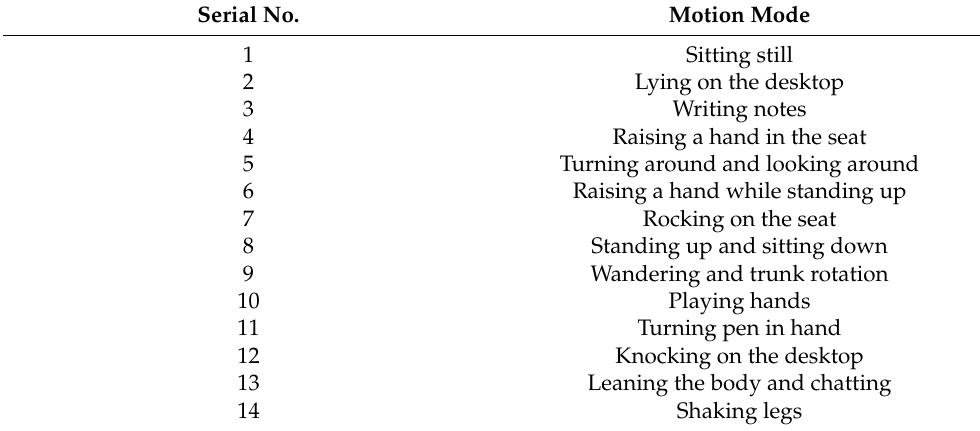
Table 1. Motion mode design. To simulate classroom behaviors for the participants, we selected 14 typical classroom behaviors. The table lists each motion’s name as well as the order in which it took place. Serial No. Motion Mode 1 Sitting still Lying on the desktop